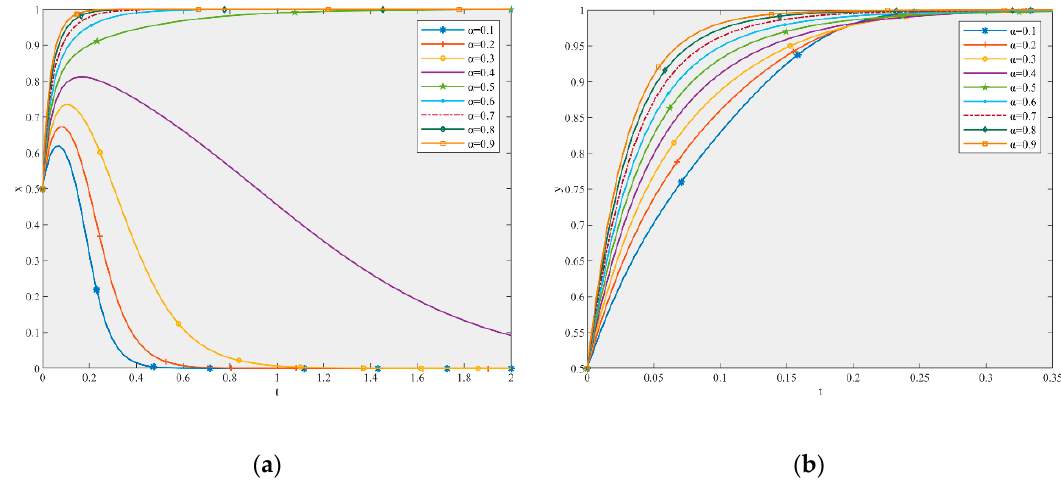
Figure 6. The e ff ect of α ( a ) on the production unit and ( b ) the recycling unit in the game Figure 6. The effect of α ( a ) on the production unit and ( b ) the recycling unit in the game equilibrium.